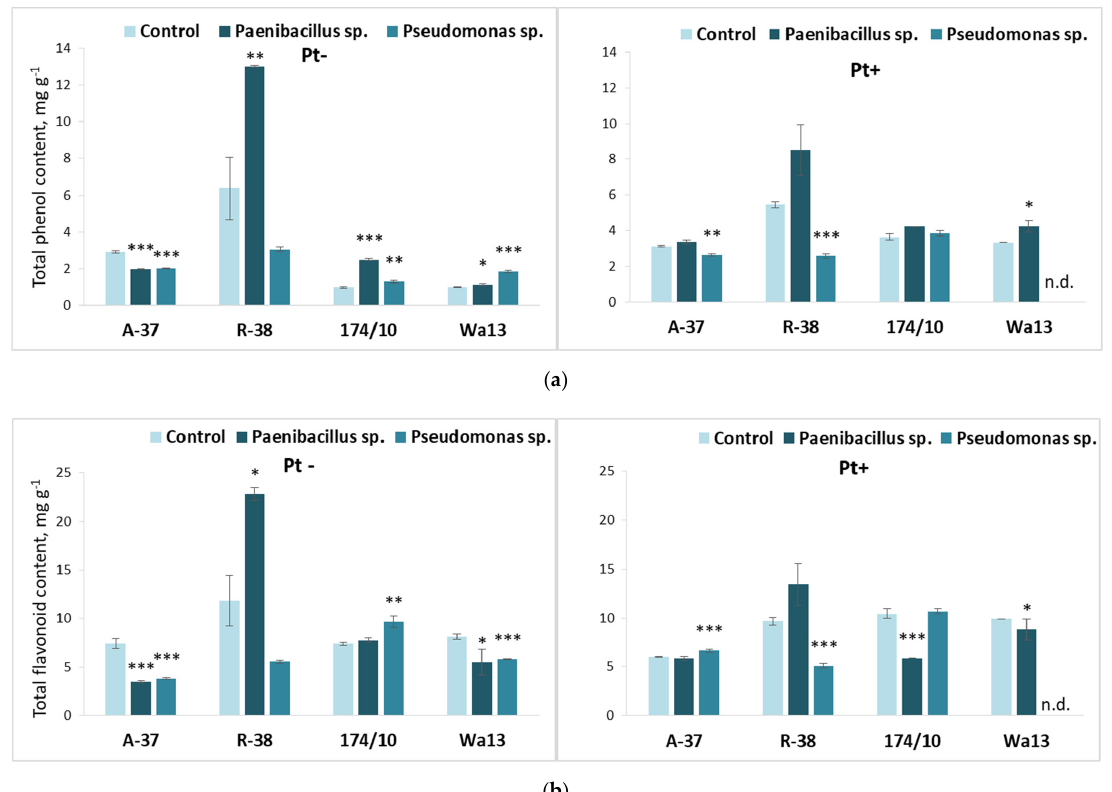
Figure 9. Average total phenol ( a ) and flavonoid ( b ) content in the leaves of different Populus genotypes (A-37 and R-38, P. tremula ; 174/10 and Wa13, P. tremula × P. tremuloides ), whose explants were first cultured on the nutrient medium inoculated with Paenibacillus sp. or Pseudomonas sp. bacteria, then transferred onto fresh nutrient medium, either sterile (‘Pt − ’) or inoculated with fungus Phellinus tremulae (‘Pt+’). Statistically significant differences from the control variant, which was not treated with bacteria during the first culture stage, are indicated (for each genotype separately): * p < 0.05; ** p < 0.01; *** p < 0.001. ‘N.d.’ means that, because of decreased explant viability, no reliable data were obtained for a particular variant.